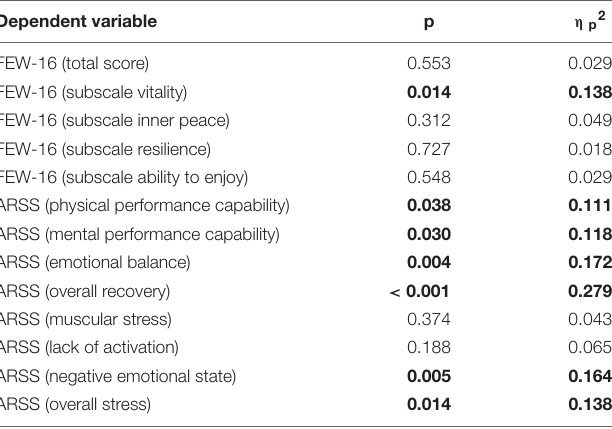
TABLE 2 | Interaction relationships for Group (CG, OPR − , OPR + , OPR ++ ) and Time (T1, T2) as predictors of the subscales in the FEW-16 and ARSS (Experiment